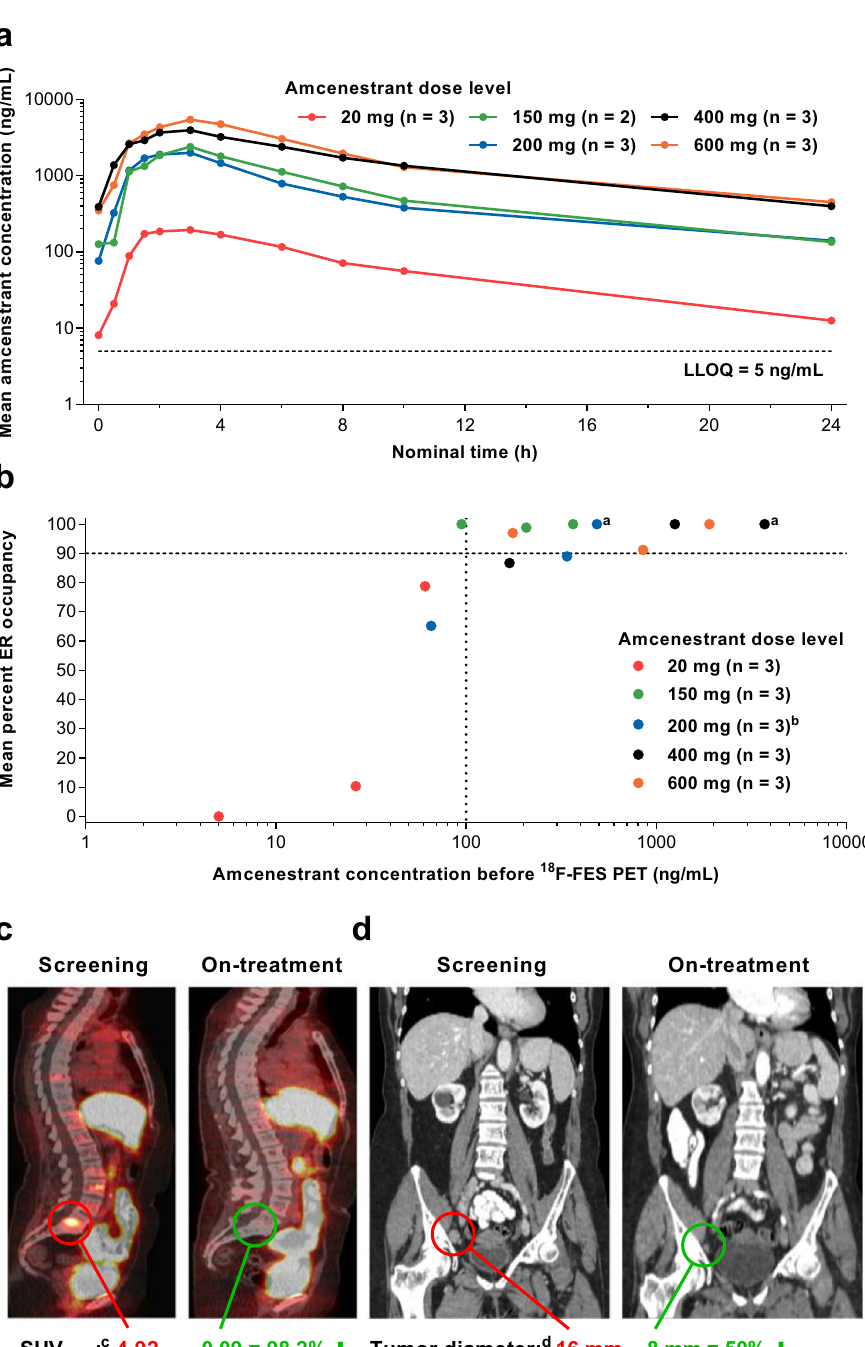
Fig. 2 Part A dose escalation: amcenestrant plasma concentration-time pro fi les, pharmacokinetic/pharmacodynamic relationships, and 18 F-FES PET/ CT images. a Mean amcenestrant plasma concentration-time pro fi les observed following repeated oral administration (cycle 1, day 22) under fasting conditions; b pharmacokinetic/pharmacodynamic relationship between plasma concentrations of amcenestrant measured just before 18 F-FES